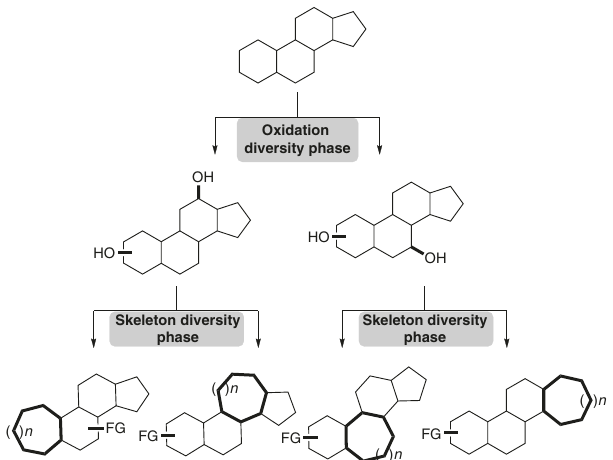
Fig. 1 Two Phases of Diversi fi cation. Starting from a polycyclic scaffold, we are able to oxidize then functionalize various natural products to